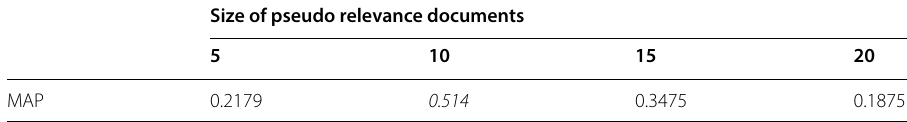
Table 5 Performance versus size of pseudo relevance documents